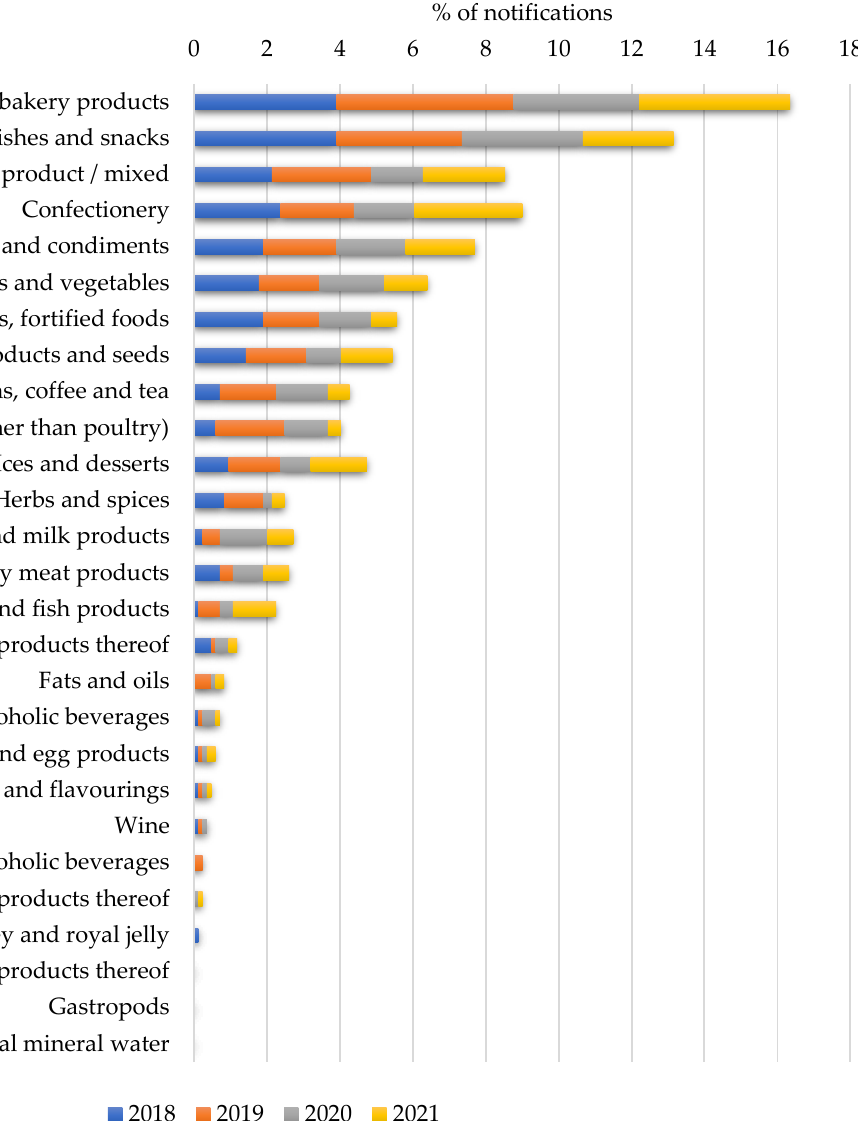
Figure 6. Percentage of notifications according to food categories per year.